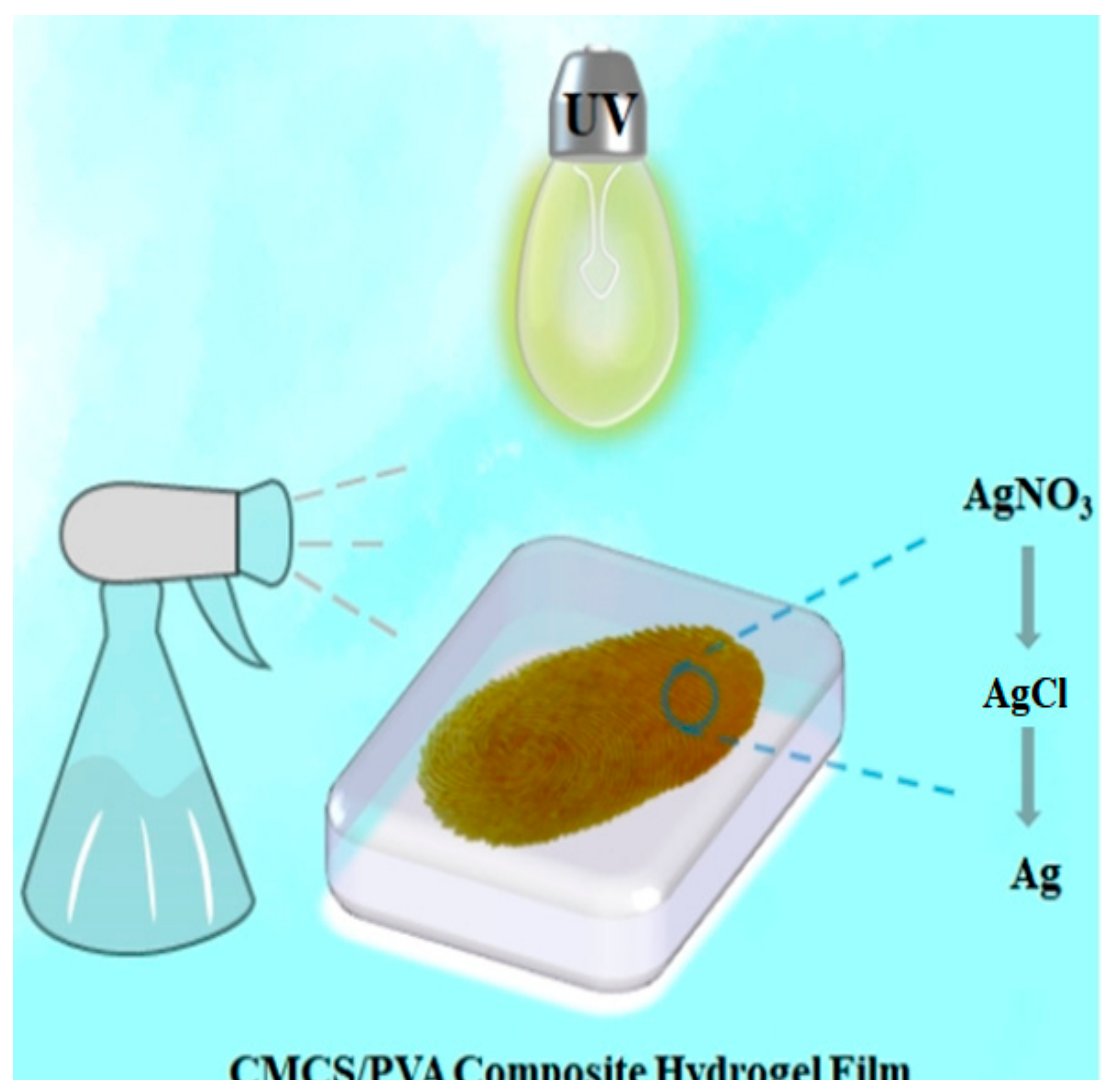
Figure 6. Schematic diagram of hydrogel fingerprint film development mechanism.